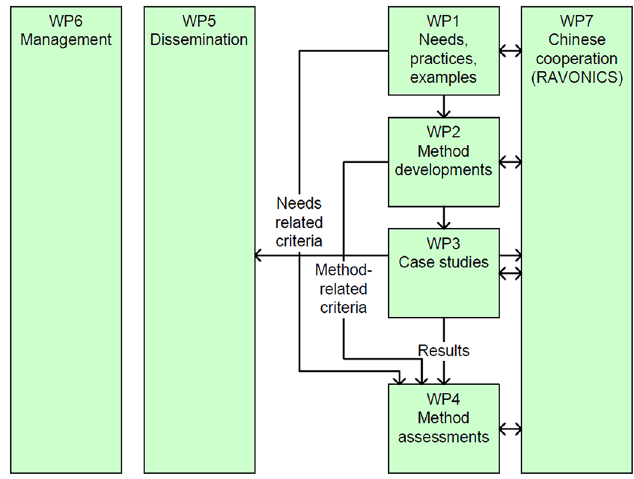
Fig. 4. HARMONICS work plan.